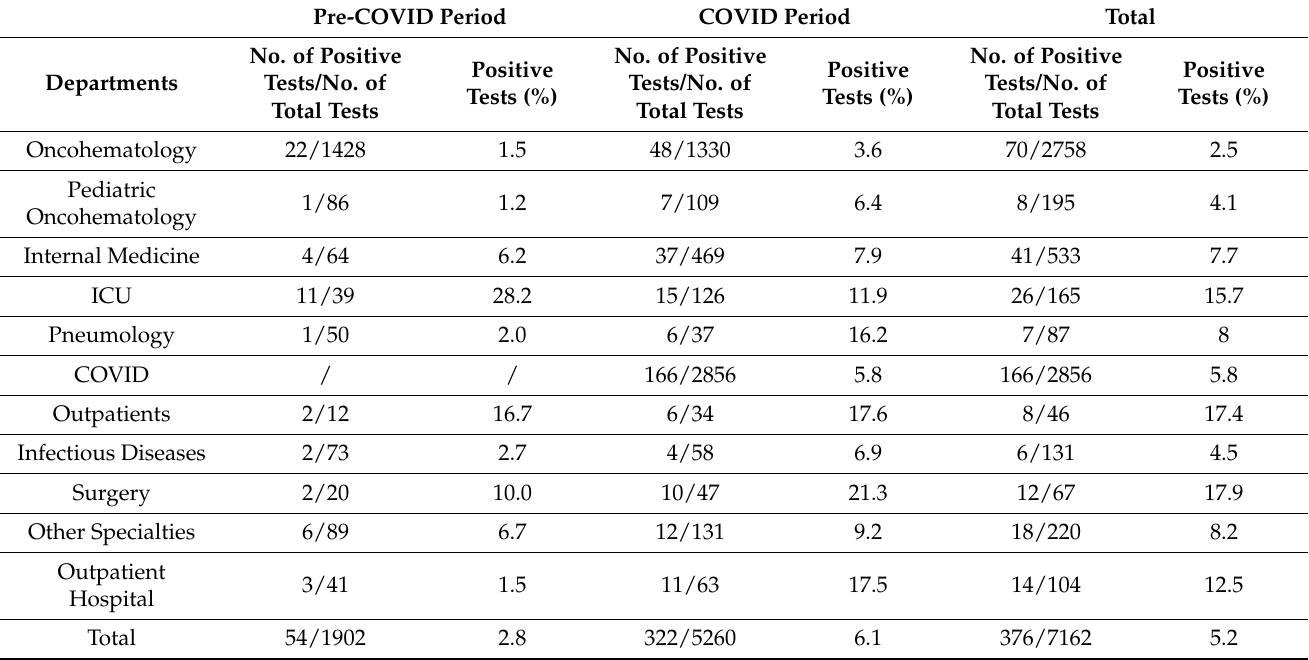
Table 1. Number of tests requested for GM-Ag and positive tests (%) in the pre-COVID and COVID